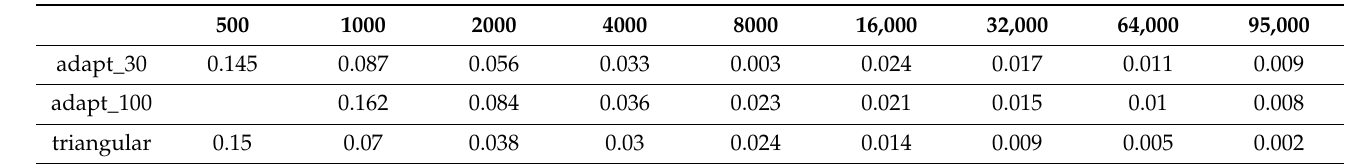
Table 4. The standard deviation in mm of the simplified models for each simplification method compared to the high-resolution